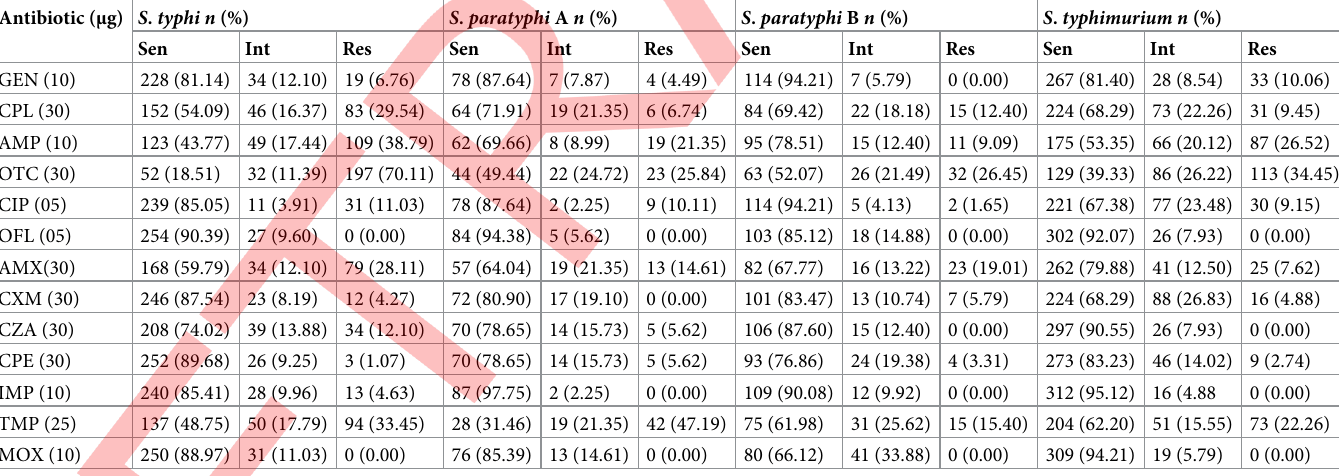
suggesting these antibiotics to be employed against S . typhi infections. Four antibiotics viz OFL, CXM, IMP and MOX were noted to be remarkably effective against S . paratyphi A infec- tion whereas this strain was identified to be highly resistant against OTC (25.84%) and TMP (47.19%). S . paratyphi A had also shown increased tendency towards switching over from sen- sitivity zone to intermediate level resistance against OTC (24.72%), TMP (21.35%), CXM (19.10%), and MOX (14.61%) suggesting a more cautious use of these antimicrobials against S. paratyphi A infection. Our results indicated that S . paratyphi A had not yet acquired multi- drug resistance against these antibiotics, therefore these drugs could be equally applied as treatment options against illness caused by this microorganism. S. paratyphi B has almost manifested similar patterns for antibiotic resistance against the tested antibiotics as that of S. paratyphi A however, the microbe depicted increased sensitivity against GEN (94.21%) and